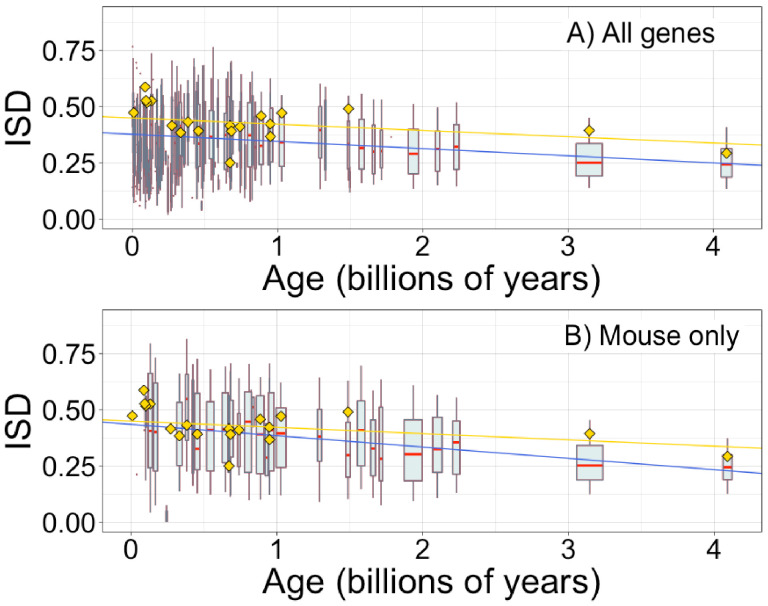
Intrinsic structural disorder (ISD) depends on age for whole genes, as previously reported by Foy et al., 2019.Each data point consists of the average across all instances of a homologous gene family (see Materials and methods) across all species (A) or just in mouse (B), dated according to the oldest pfam the gene contains. Each age class is represented by a weighted box plot, where the width of the plot indicates the number of gene families in that age class. The median is shown in red, with the boxes representing upper and lower quartiles (the 75th and 25th percentile), and the whiskers indicating 9 and 91 quantiles. For age classes with only a single gene family, values are presented as small red dots. For clarity of presentation our plots do not show outliers, although we note that these are included in our linear regression models. (A) Blue slope = −0.032, R2 = 0.057, p = 1 × 10−229. (B) Blue slope = −0.050, R2 = 0.091, p = 3 × 10−85. Slope represents the decrease in average IUPred2 score, that is, the predicted propensity of the average amino acid to be disordered, per billion years. Yellow points show the average ISD scores and phylostratum assignments taken from Foy et al., 2019 and assigned dates using our scheme, with corresponding yellow linear regression with age (slope = −0.028, R2 = 0.042, p = 3 × 10−136). Our improved gene age assignments thus increased the strength of the relationship for mouse genes, where the relationship is stronger than for genes across all taxa.